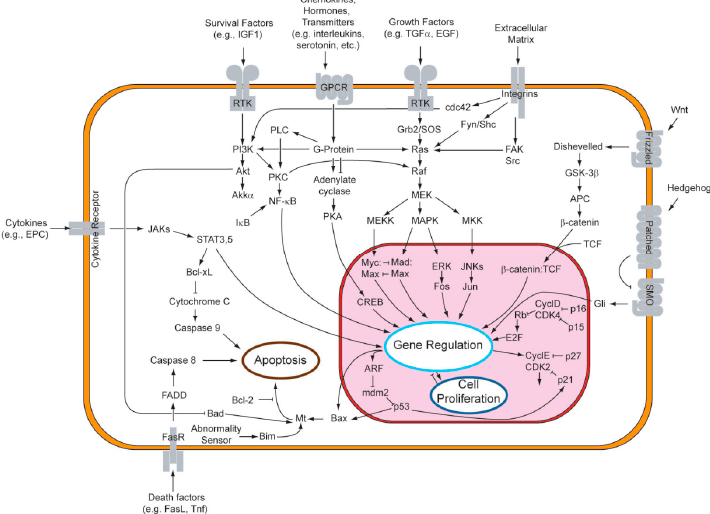
Figure 3. Main intracellular signaling pathways. From: Wikipedia . Wikimedia Foundation, Inc.